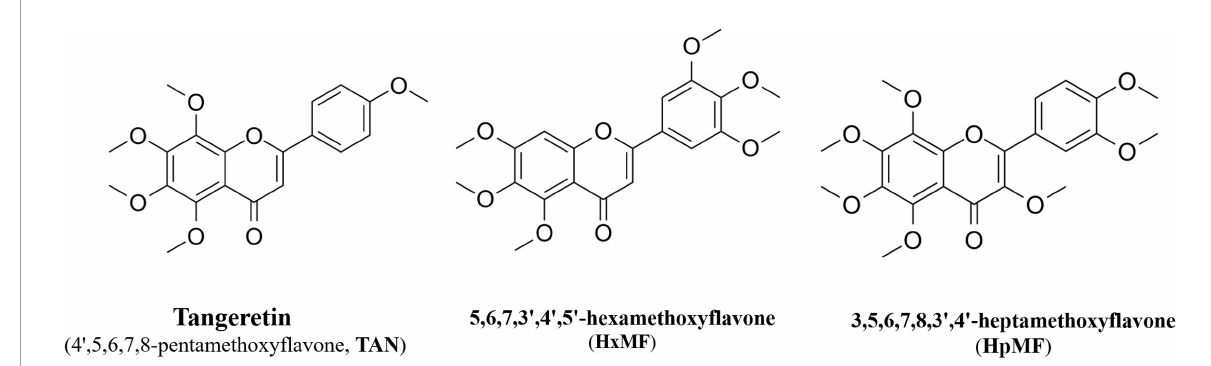
FIGURE1 Structures of 4 (cid:48) ,5,6,7,8-pentamethoxyflavone (tangeretin, TAN), 5,6,7,3 (cid:48) ,4 (cid:48) ,5 (cid:48) -hexamethoxyflavone (HxMF), and